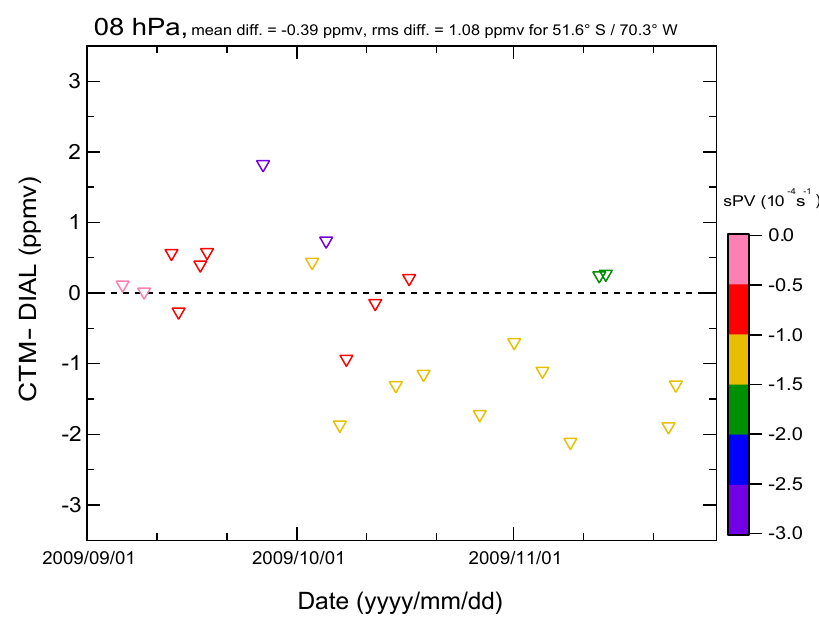
Figure 12. Time series of differences in O 3 mixing ratios as measured by DIAL and computed by MIROC-CTM at 8hPa from September to November 2009, over the OAPA site. Data are color coded based on sPV values for